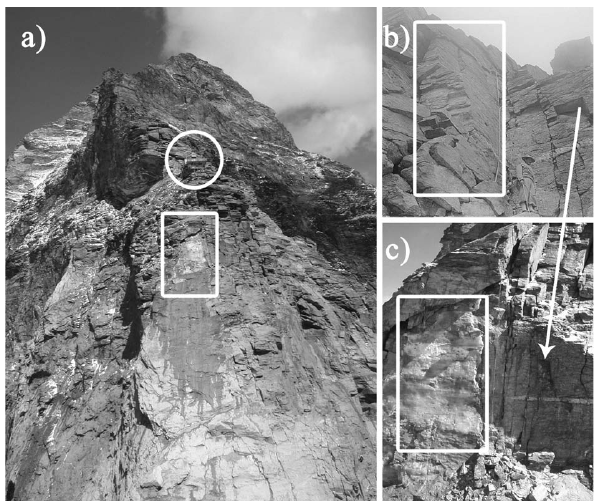
Fig. 2. Views of the Chemin´ee rockfall scar: (a) view from the bottom upwards: the Carrel hut is in the circle; the rockfall scar is in the square. Beneath the square, the water is clearly visible coming from joint ice melting (image courtesy of Valle d’Aosta Re- gion, Italy); (b) historical image of the slope before the event (in the square the rock mass which detached on August 2003); (c) the area after the event: the square highlights the ice lens exposed after the detachment (images courtesy of L. Trucco).